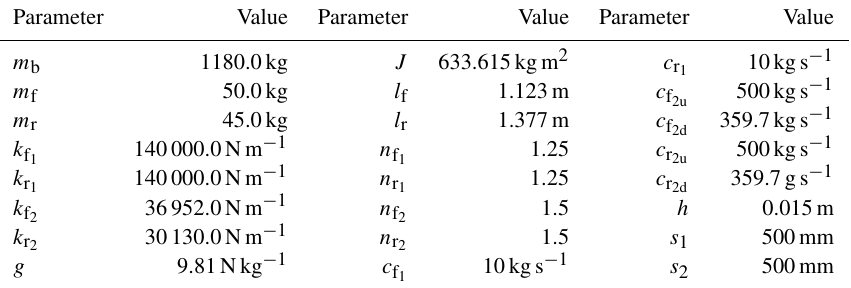
Table 2. Specific parameters set in numerical